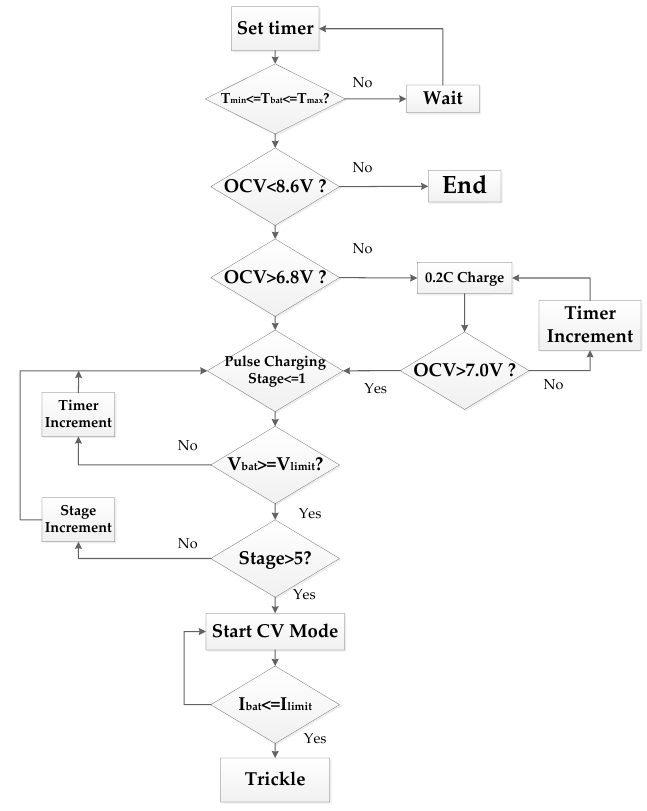
Figure 4. Proposed multistage pulse charging operation flowchart.